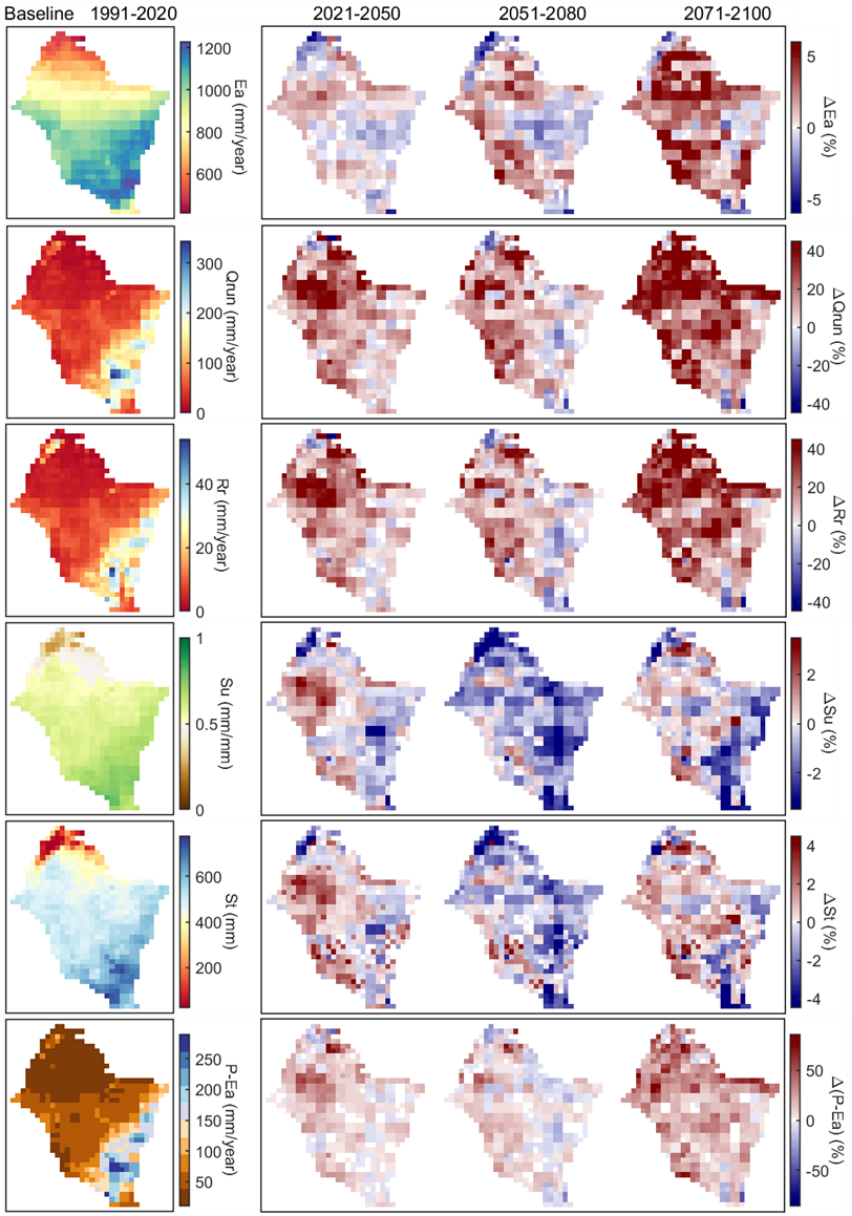
Figure 11. Spatial patterns of the long-term average of annual hydrological variables and water availability over the historical period (1991– 2020) and changes over future periods (2021–2100) under RCP8.5 (median of 18